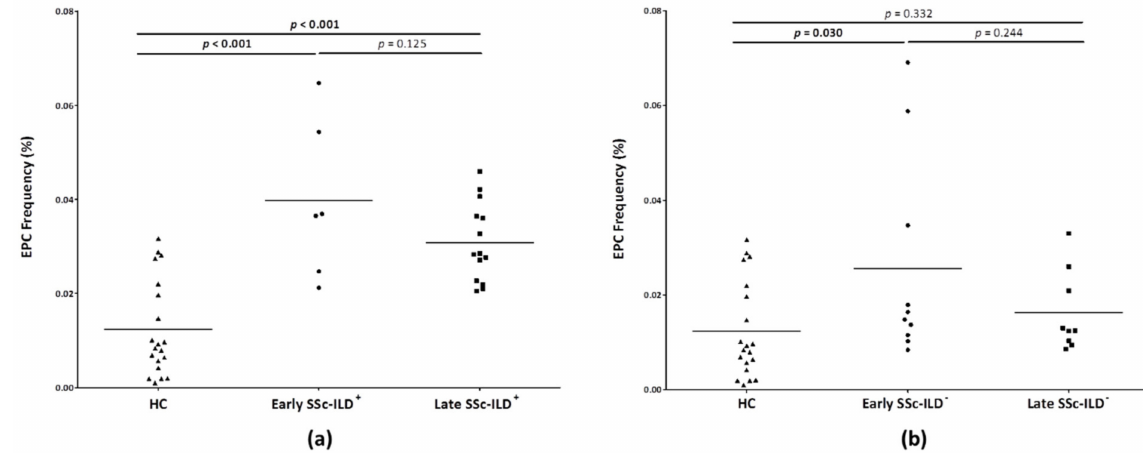
Figure 2. Quantification of EPC population by flow cytometry in HC and patients with SSc-ILD + and SSc-ILD − stratified according to SSc duration. ( a ) EPC frequency in HC and patients with early and late SSc-ILD + . ( b ) EPC frequency in HC and patients with early and late SSc-ILD − . EPC were considered as CD34 + , CD45 low , CD309 + , and CD133 + cells in the lymphocyte gate and are expressed as the percentage of cells in this gate. Differences between the study groups were evaluated by Student’s t -test. p -values < 0.05 were considered as statistically significant. Horizontal bars indicate the mean value of each study group. EPC: endothelial progenitor cells; HC: healthy controls; SSc: systemic sclerosis; ILD: interstitial lung disease.